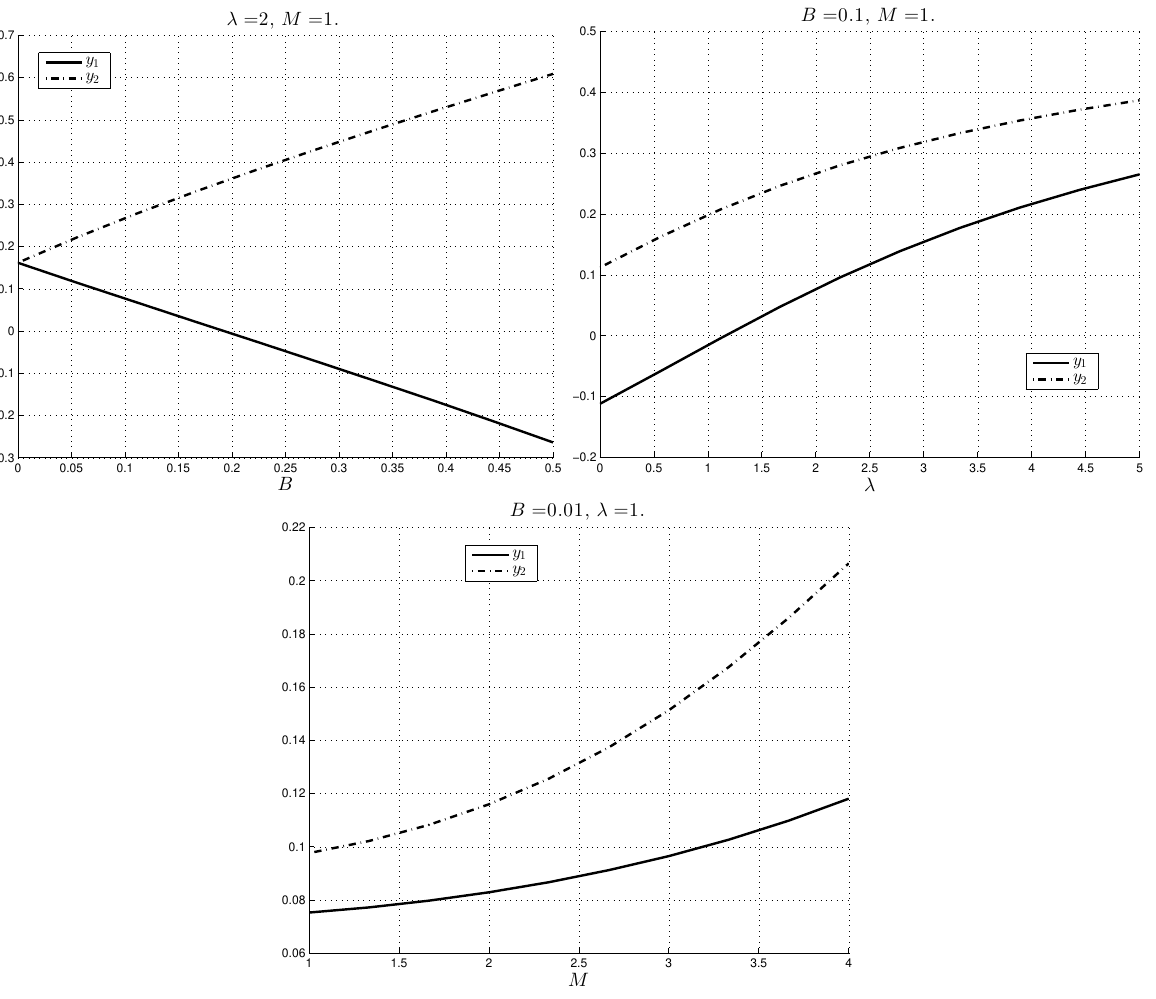
Figure 16. Case 1M : plug boundaries ( y 1 , y 2